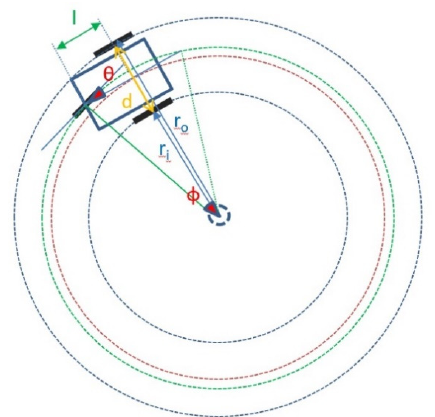
Figure 3. The geometry of the vehicle implies a specific set of calculations in order to feed the low-level control components with the necessary information for turning at a given radius, speed.